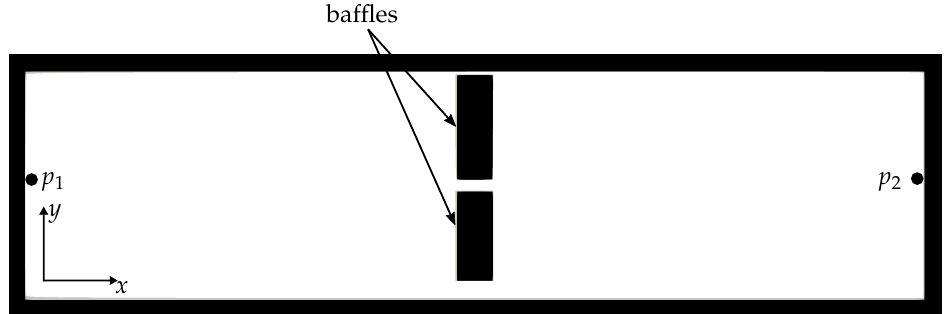
Figure 8. Cross-section of tank showing position of baffles and pressure sensors of violent slosh test case.